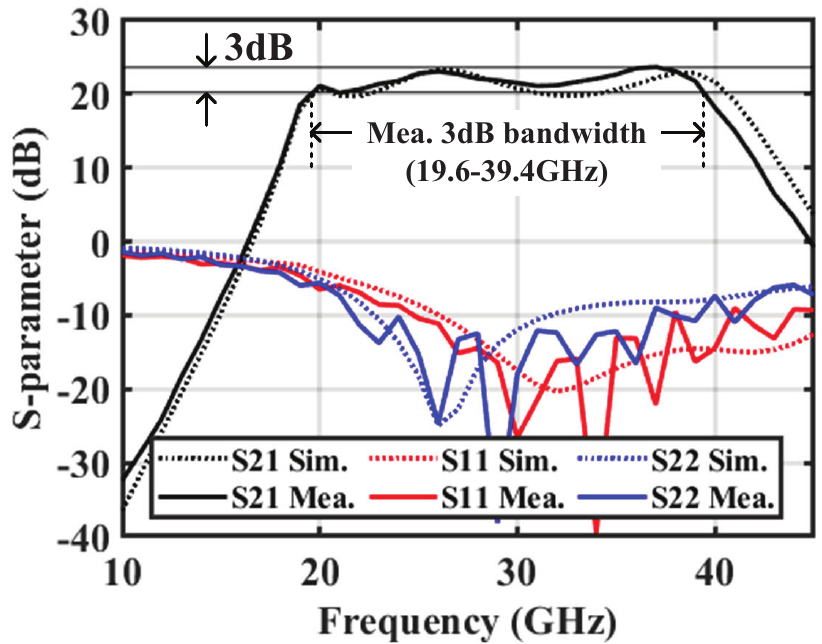
Figure 6. Simulated and measured S parameters of the LNA.